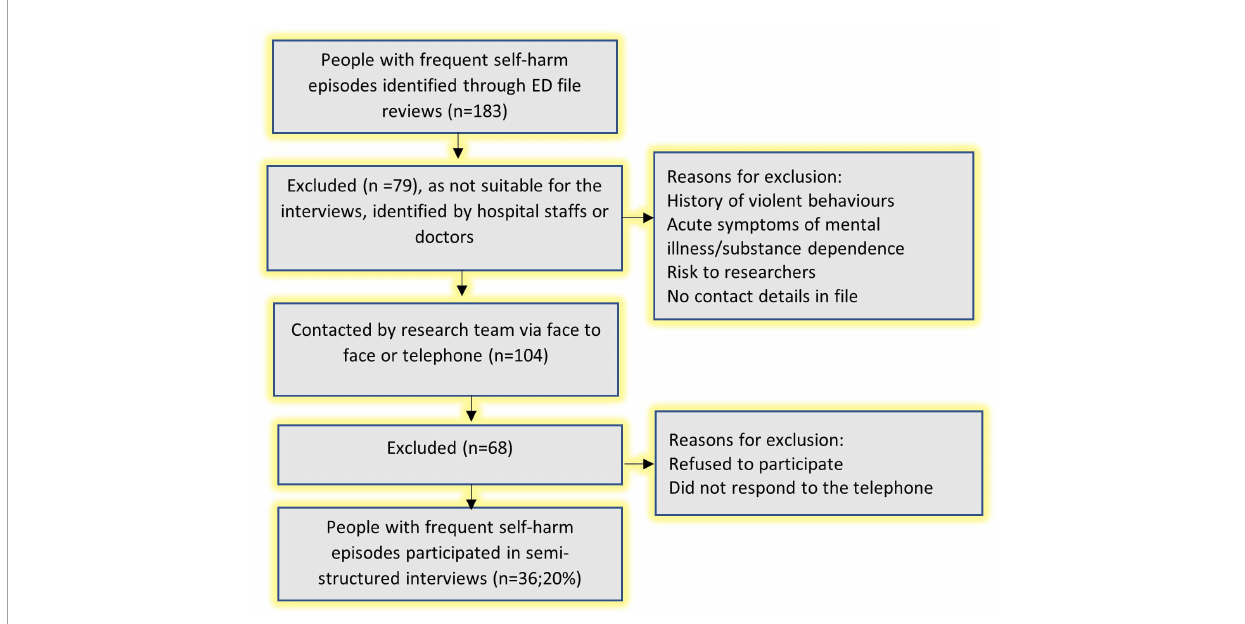
FIGURE2 Recruitment of individuals with frequent self-harm episodes for semi-structured